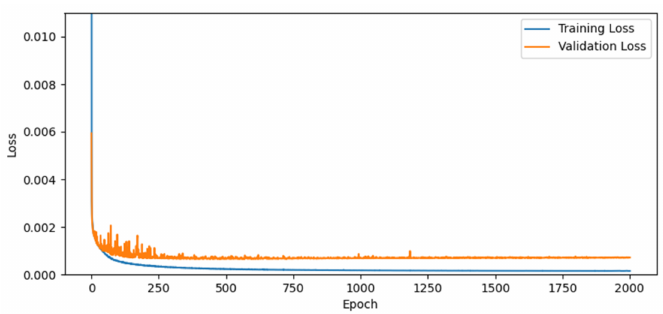
Figure 7. Training and validation losses of proposed